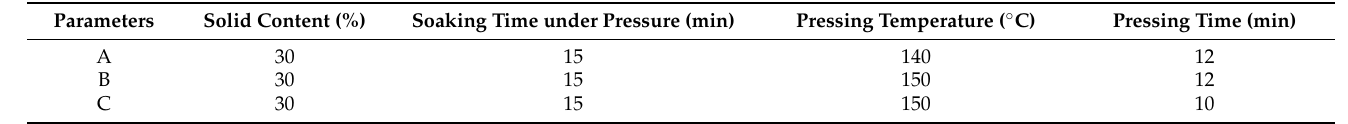
Table 1. Processing parameters used for the production of MGE plywood in this study.